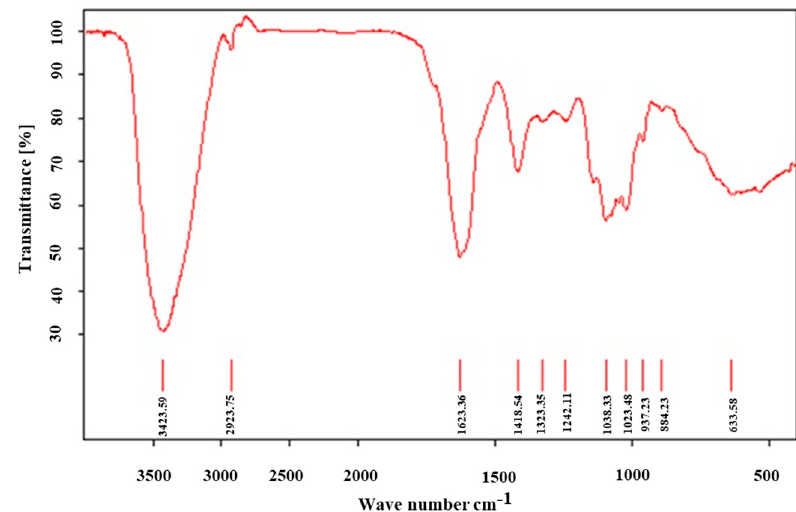
Figure 1. FR-IR spectrum of LTC-1 from P. corbieri Levl.